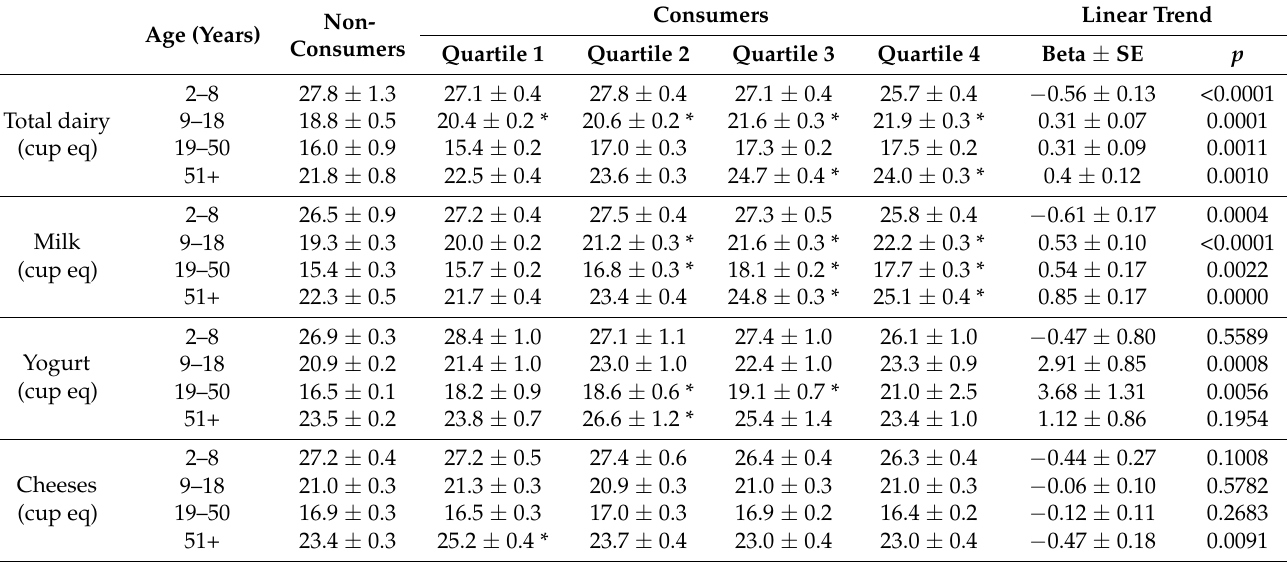
Table 3. Serum folate status (ng/mL) by dairy intake in different age